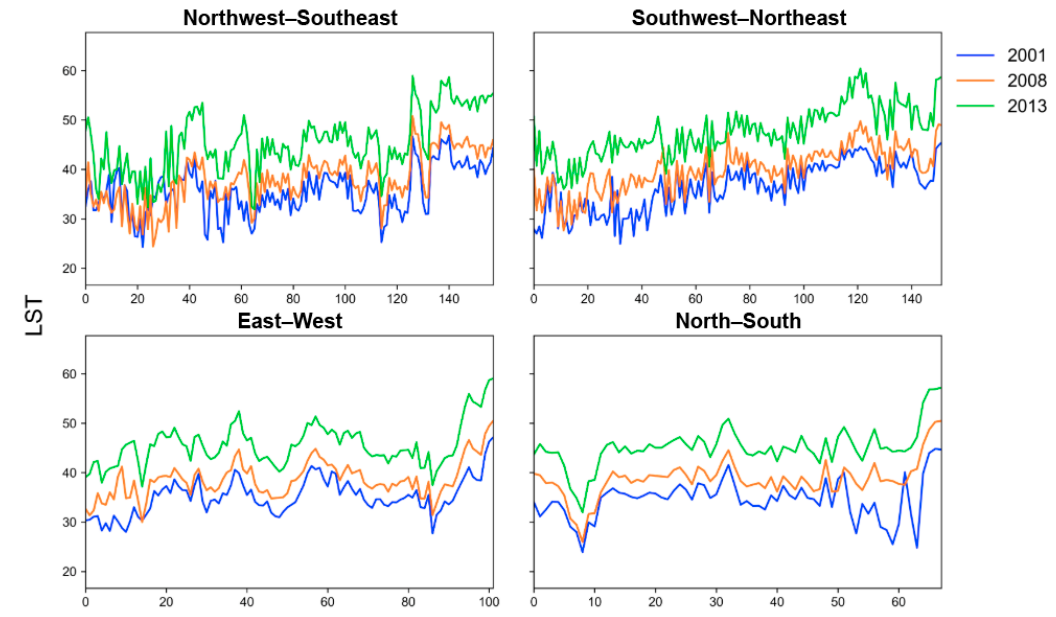
Figure 4. Multidirectional and multitemporal LST profiles along the urban–rural gradients.